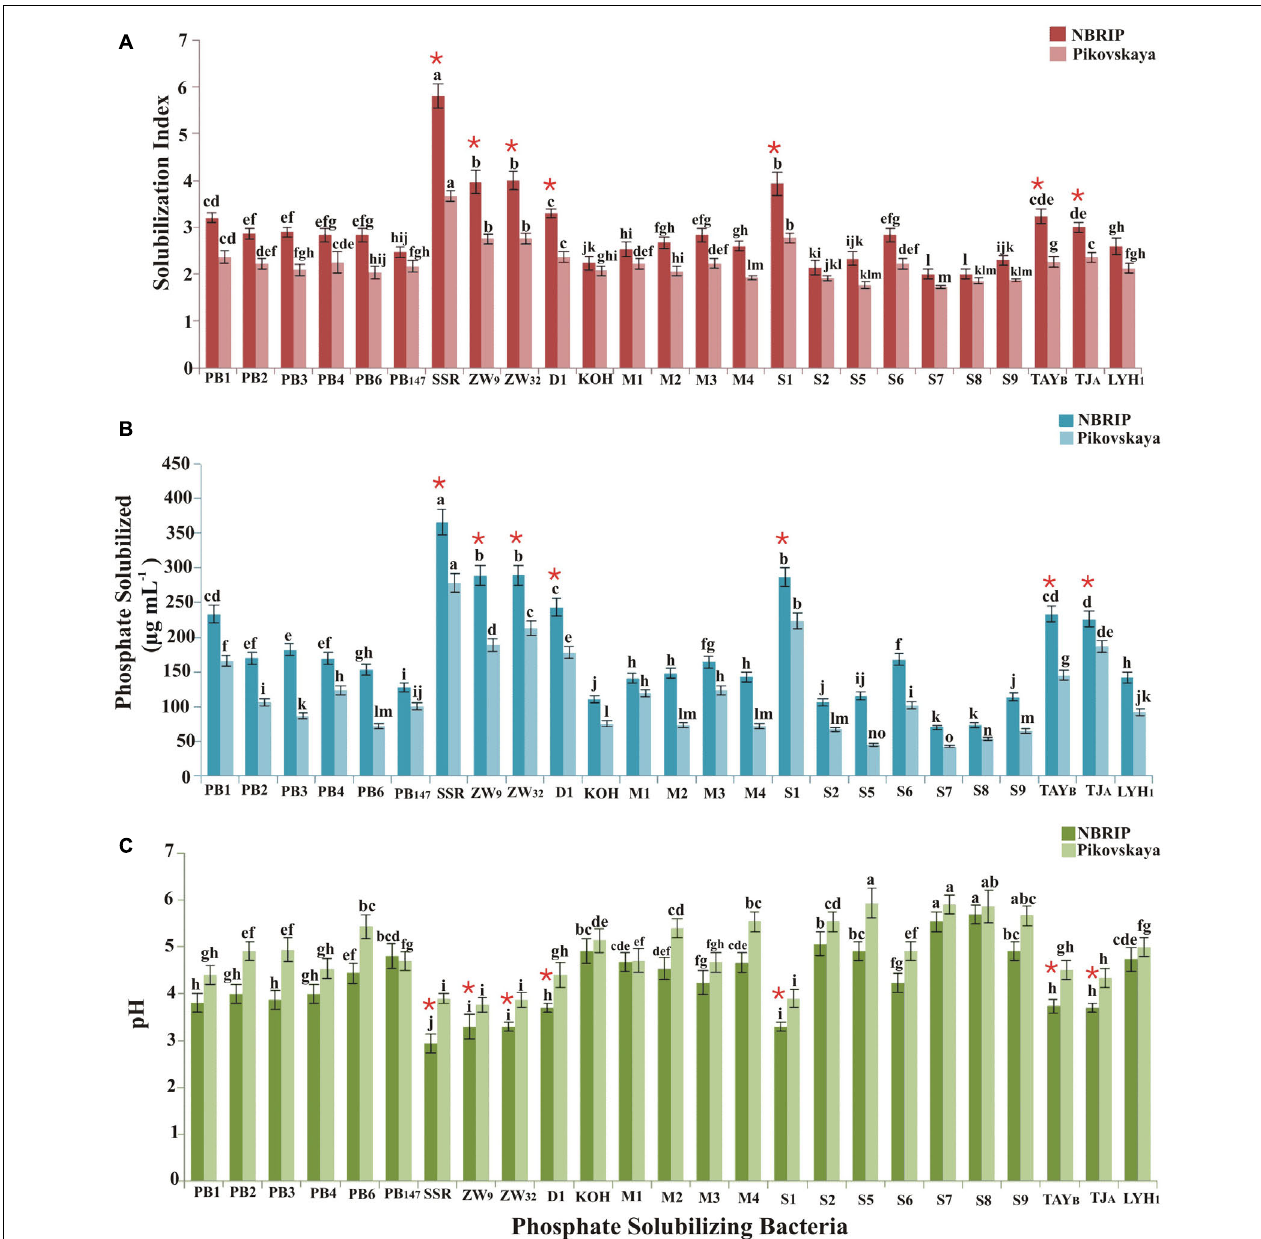
FIGURE 2 | Mineral phosphate solubilization by PSB isolated from different wheat-growing agro-ecological zones of Pakistan. P solubilizing index was calculated from halo zone formation on NBRIP and Pikovskaya’s agar medium (A) . Quantification of P solubilized by PSB in liquid NBRIP and Pikovskaya’s medium (B) . pH of medium (initial pH 7) at seventh day of pot inoculation (C) . There were six biological replicates, and standard error of the means is represented as bars. The significant difference ( p < 0.01) among treatments is denoted as means and represented by different letters (a, b, c). * PSB showing significantly higher P solubilizing index and P solubilized, while significantly lowering the pH of the NBRIP and Pikovskaya’s medium. ZW9, ZW32, and D1 are Enterobacter spp.; SSR: Ochrobactrum sp.; S1: Pantoea sp.; TJA: Pseudomonas sp.; and TAYB: Bacillus